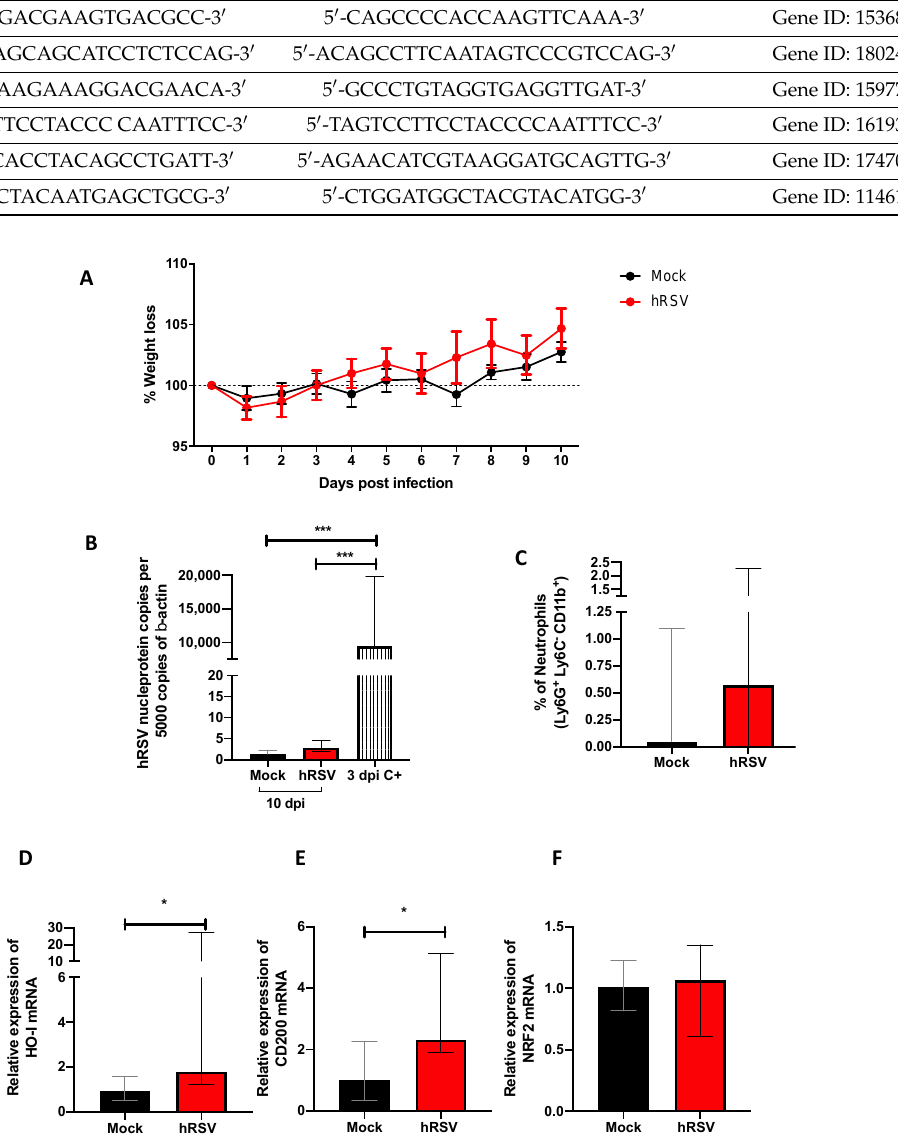
Figure 1. Evaluation of infection, inflammation, and immunomodulatory parameters from human respiratory syncytial virus (hRSV)-infected mice. ( A ) Body mass loss of C57BL/6 mice infected with 1 × 10 7 plaque formation units (PFU) of hRSV A2 for ten days. All the following parameters were measured at day 10 post hRSV infection. ( B ) Determination of viral load through specific real-time quantitative reverse transcription polymerase chain reaction (RT-qPCR) for hRSV. ( C ) Neutrophils ( D ) Heme Oxygenase (HO)-1, ( E ) OX-2 glycoprotein membrane (CD200), and ( F ) nuclear factor erythroid 2-related factor (NRF2). Data are shown as median ± interquartile range of at least two independent experiments with three animals per group. ( B ) One-way ANOVA was performed with a post-hoc Tukey test. ( C – F ) t-student was performed with the Mann-Whitney U test (* p < 0.05; *** p ≤ 0.001). Created with